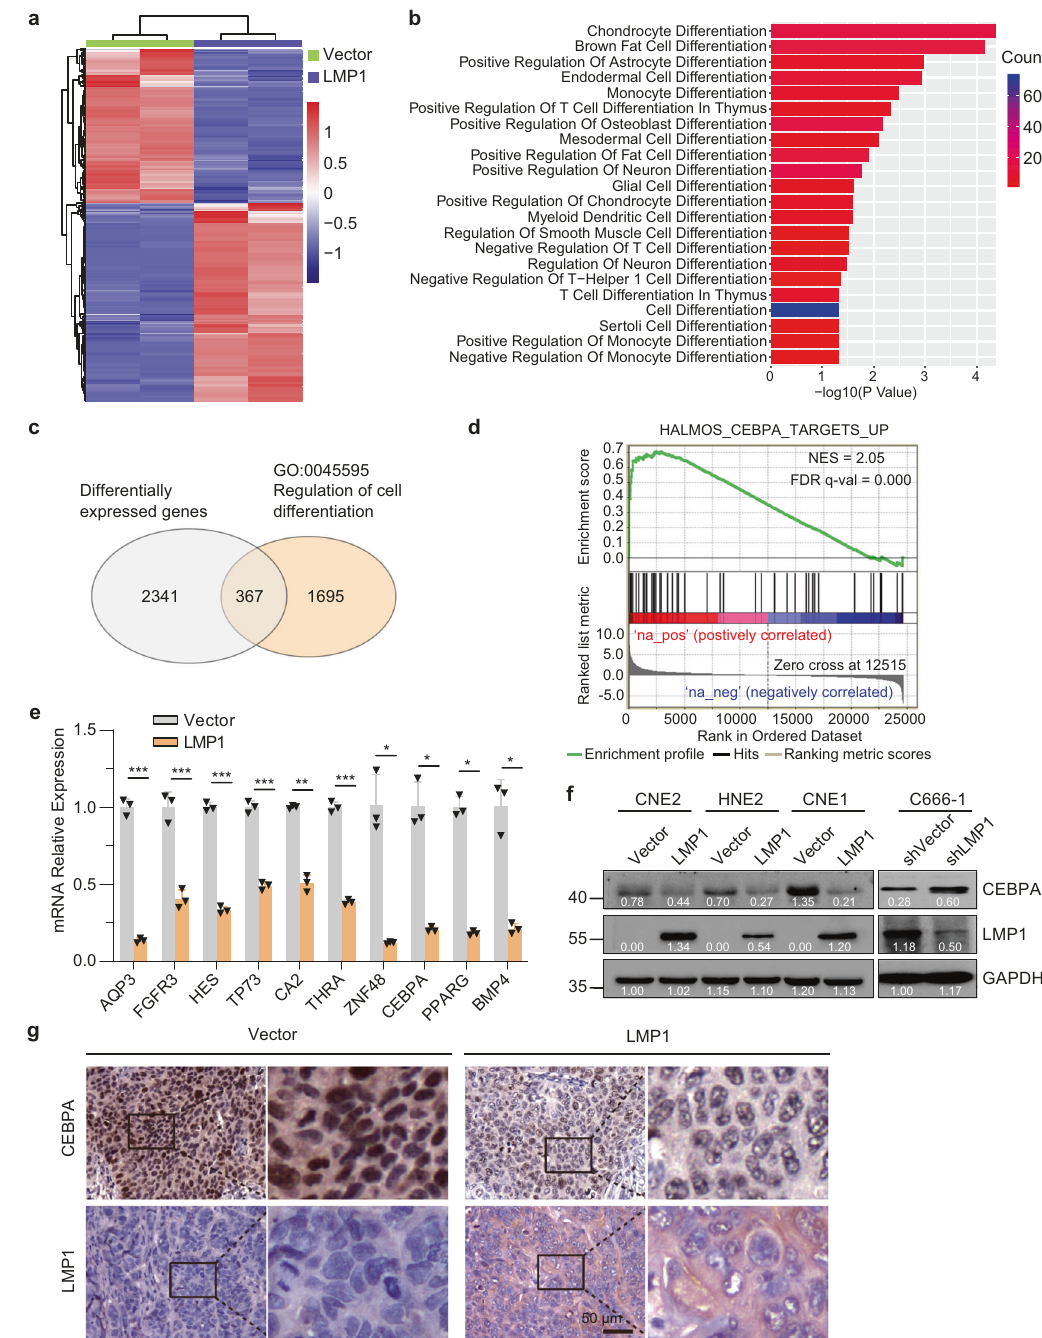
Fig. 2 LMP1 signaling inhibits CEBPA transcription in the NPC-derived cells. a Heatmap analysis showing signi fi cantly differentially expressed genes (fold change >2) in the CNE1-TetOn-LMP1 (LMP1) cells compared to the CNE1-TetOn-Vector (Vector) cells after 100 ng/ml Dox treatment for 48 hours. b Functional categorization of differentially expressed genes analyzed for GO biological processes. c In all, 367 differentially expressed genes are cell differentiation-related genes, analyzed by g: Pro fi ler. d GSEA analysis indicates enriched expression of direct CEBPA transcriptional targets upon induction of LMP1. e Differentially expressed genes in GO term “ regulating of cell differentiation ” , including CEBPA, were validated by RT-qPCR. f CNE1/HNE2/CNE2-TetOn-LMP1 and CNE1/HNE2/CNE2-TetOn-Vector cells were treated by 100 ng/ml Dox, or knockdown of LMP1 in C666-1 cells for 48 hours, and then the expression of CEBPA was measured by immunoblotting. g IHC staining of CEBPA expression in sections from xenografts of CNE1-TetOn-LMP1. Statistics, signi fi cance: * P < 0.05, ** P < 0.01, *** P < 0.001; two-tailed Student ’ s t- tests stem-like markers in these tissue samples (Fig. 4g, upper panel). To dissociated tumor tissues and investigated the expression of the eliminate the normal cells from the tumor tissues, tumor tissues differentiation markers. Consistent with the in vitro results, were digested and then cultured in the selection medium with restoration of CEBPA increased the expression of differentiation puromycin for 24 hours. Similar results were again observed in the markers and decreased the expression of undifferentiated and Signal Transduction and Targeted Therapy (2021)